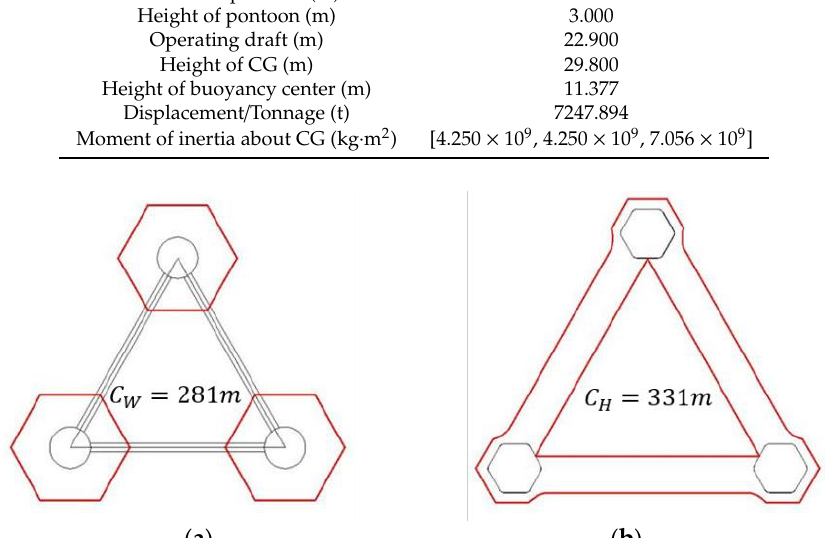
Figure 5. The total circumferences of ( a ) WindFloat-type platform and ( b ) HexaSemi.